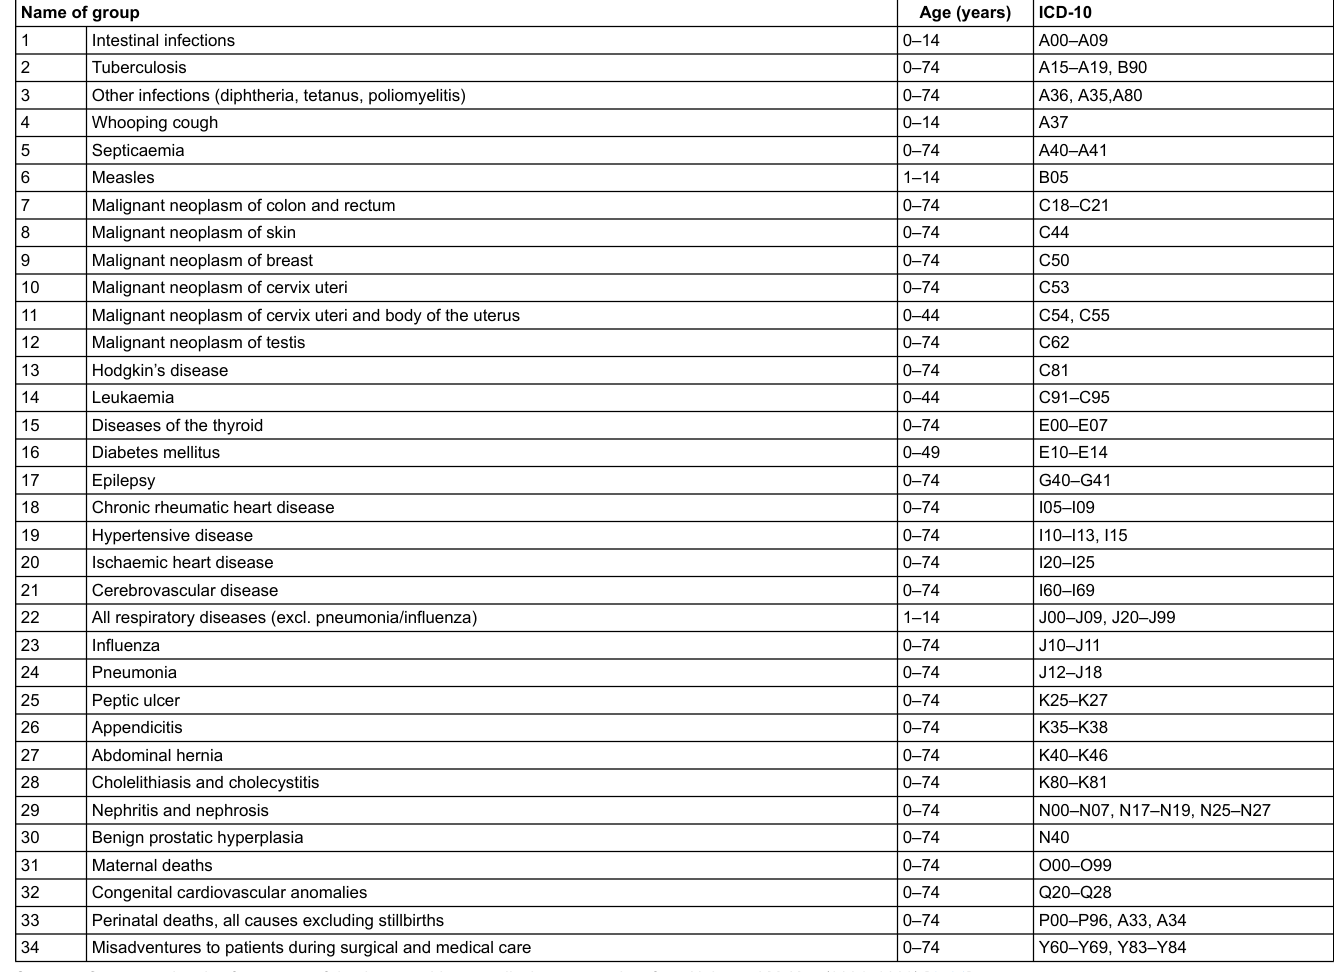
Table 1: Causes of death amenable to